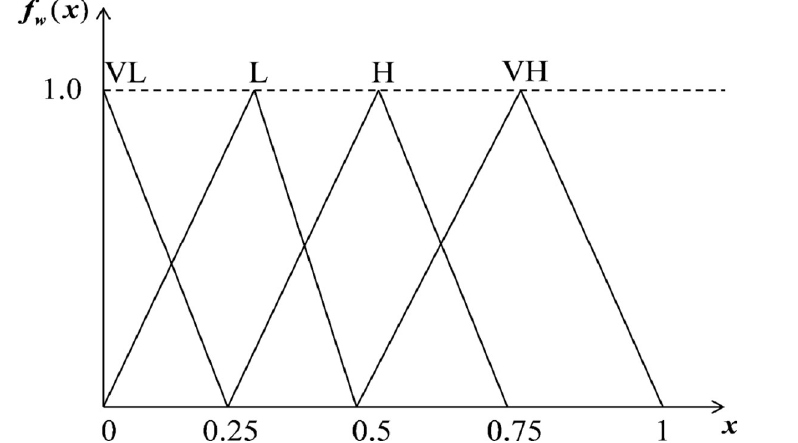
Fig 2. Membership functions of linguistic variables for the importance weight of criteria.